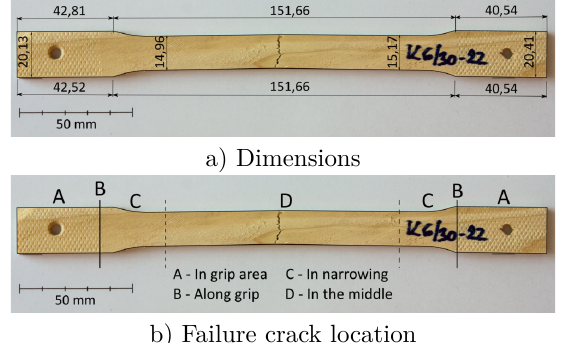
Figure 1. Dog bone sample.